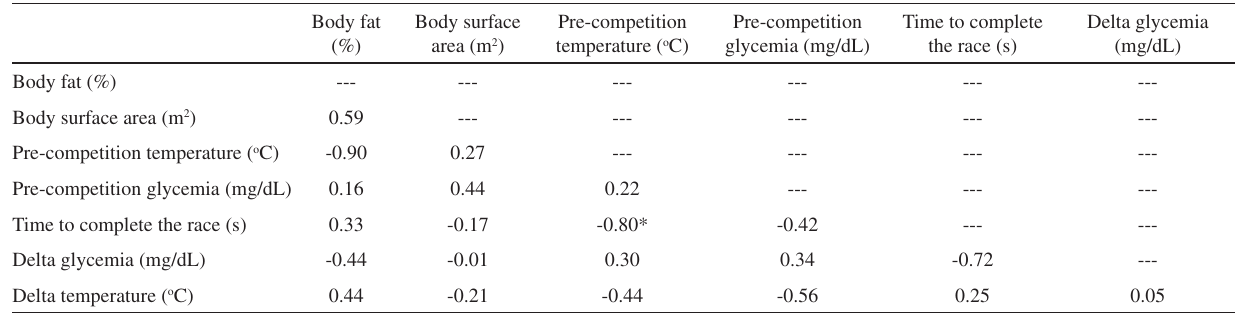
Table 2 - Bivariate linear correlation between anthropometric and performance data among men (n=7)